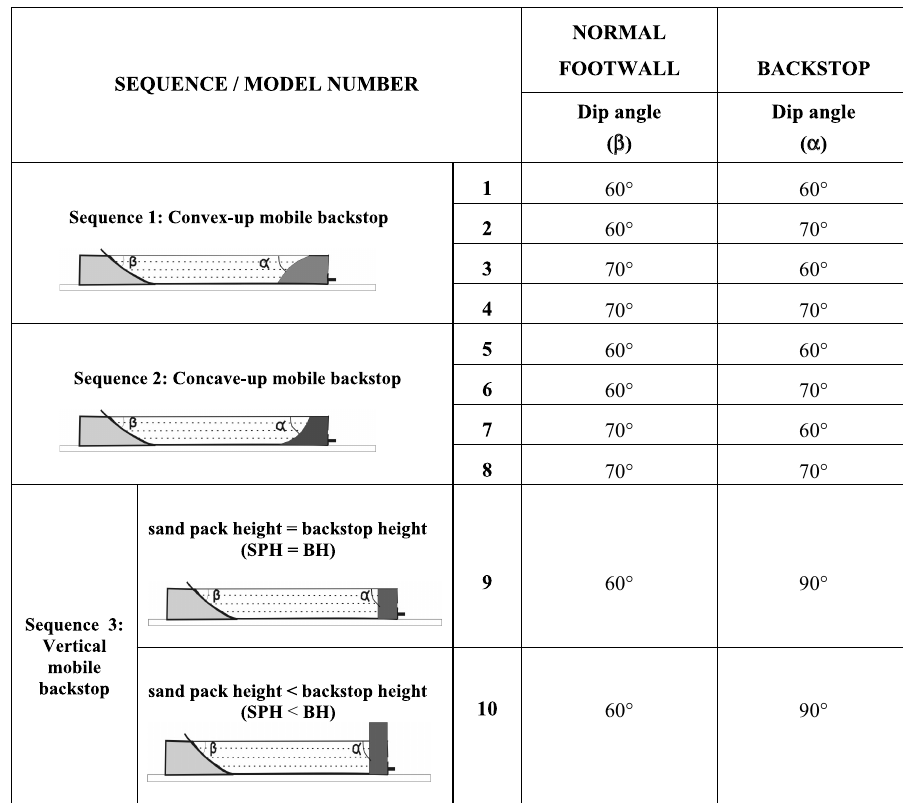
Summary of boundary conditions of our 10